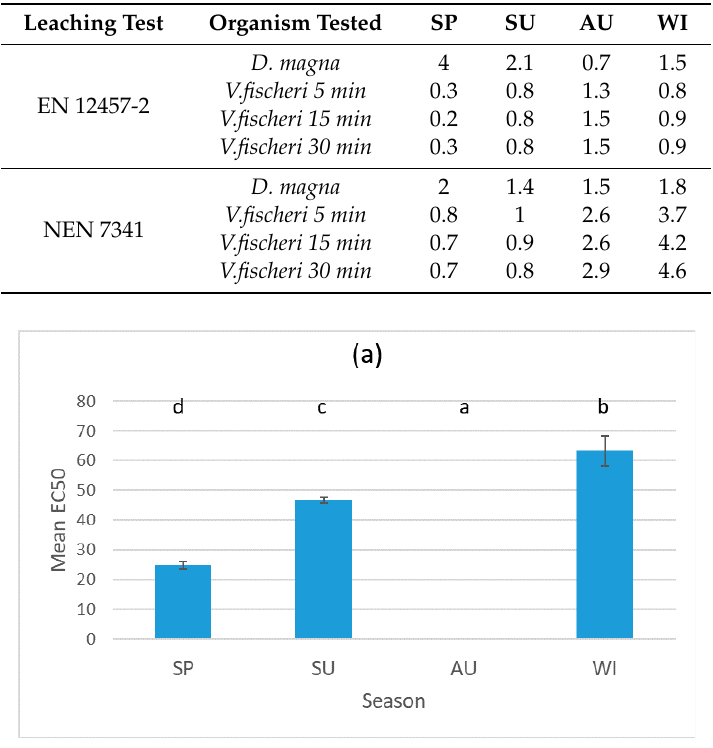
Table 2. Toxic units (Tus) calculated according to [34] for the four sludges and for both leaching tests and organisms tested.